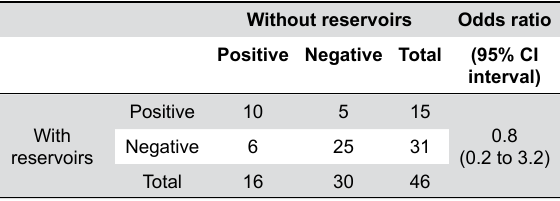
Table 2 - Matched tabulation of the absolute risk of tooth sensitivity for both groups along with the odds ratio and 95% confidence interval